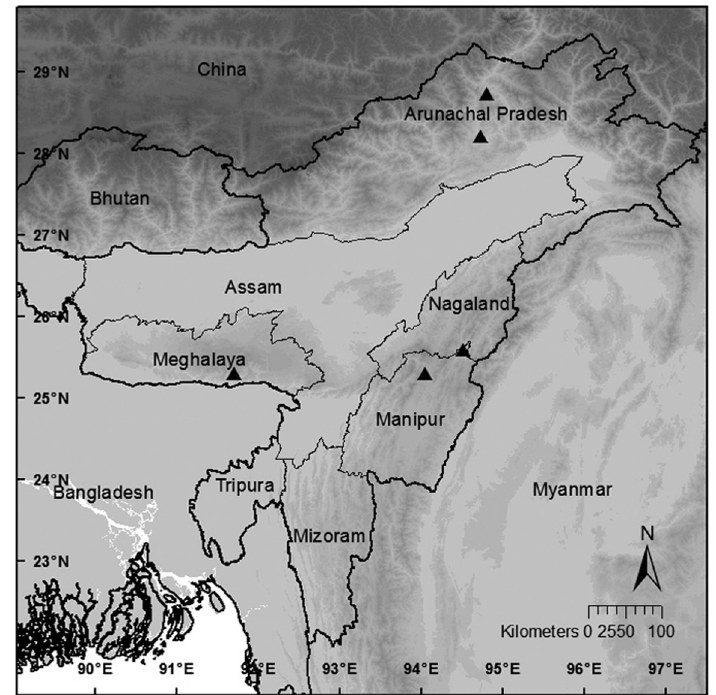
Fig. 48. Map showing the location of B. picta Sm.